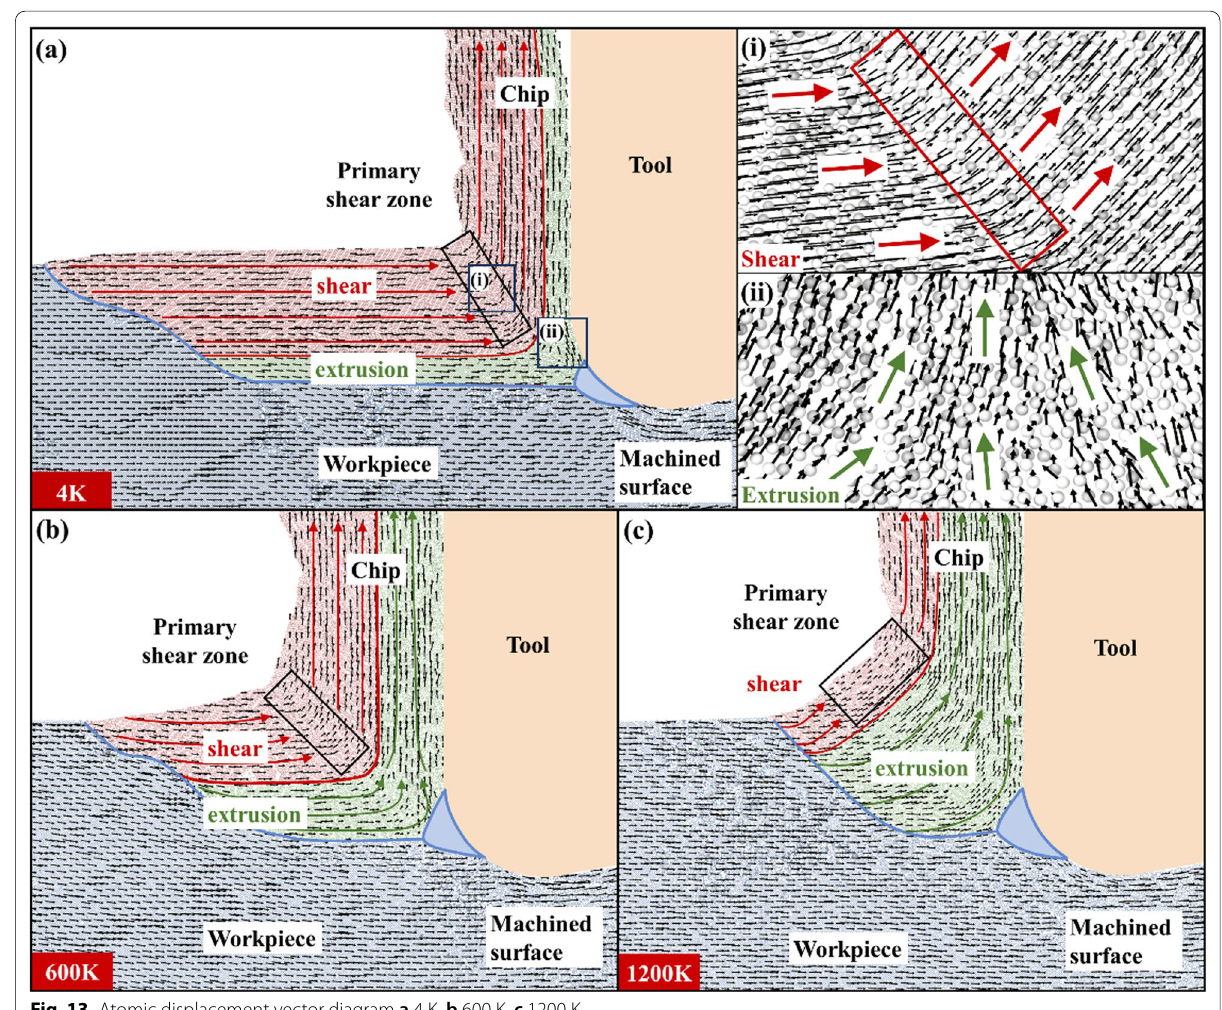
Fig. 13 Atomic displacement vector diagram a 4 K, b 600 K, c 1200